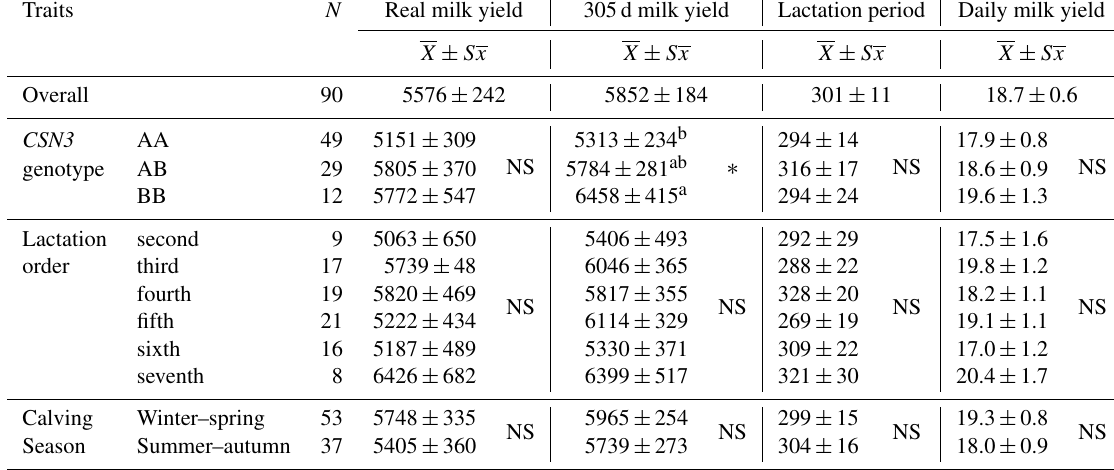
Table 2. Averages and standard error (kg) in terms of actual milk yield, 305d milk yield, lactation period, and daily milk yield traits. Traits N Real milk yield 305d milk yield Lactation period Daily milk yield X ± Sx X ± Sx X ± Sx X ± Sx Overall 90 5576 ± 242 5852 ± 184 301 ± 11 18.7 ± 0.6 CSN3 AA 49 5151 ± 309